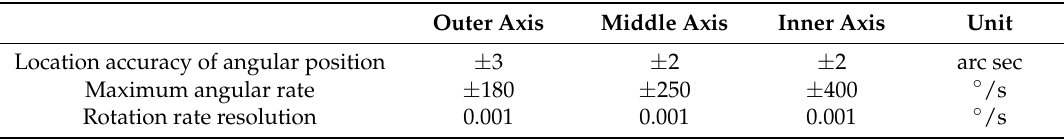
Table 1. The technical indexes of the SGT-8 three-axis turntable.